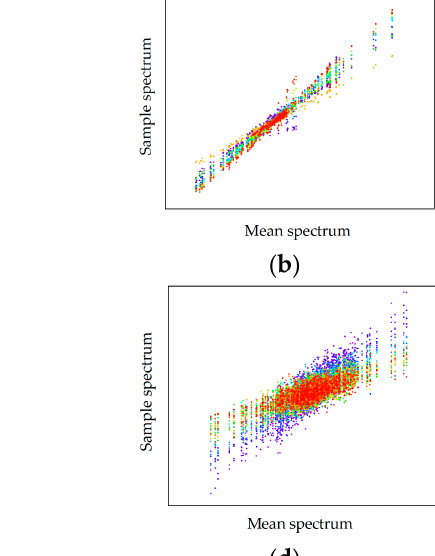
Figure 8. Raman scatter effects plot for evaluation of needed preprocessing of spectral data. ( a , c ) Show scatter effects of raw spectral data and ( b , d ) show scatter effects after preprocessing. The sample order is sorted from red to blue.